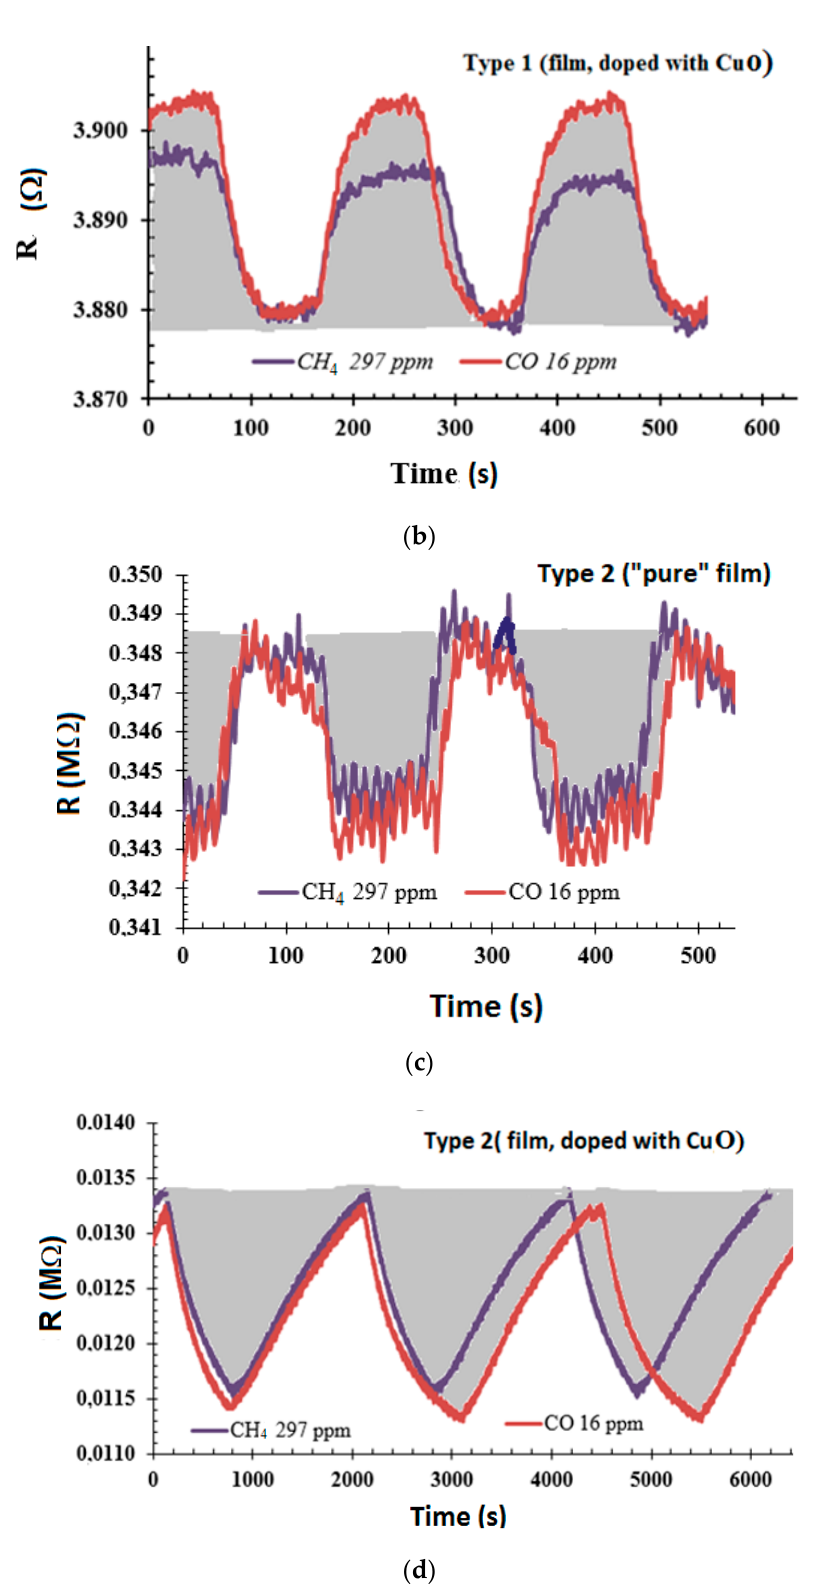
Figure 7. Typical dynamic response of the ( a , b ) type-1 and ( c , d ) type-2 sensors toward 16 ppm CO and 297 ppm CH 4 at 200 °C. Grey represents gas inputs.